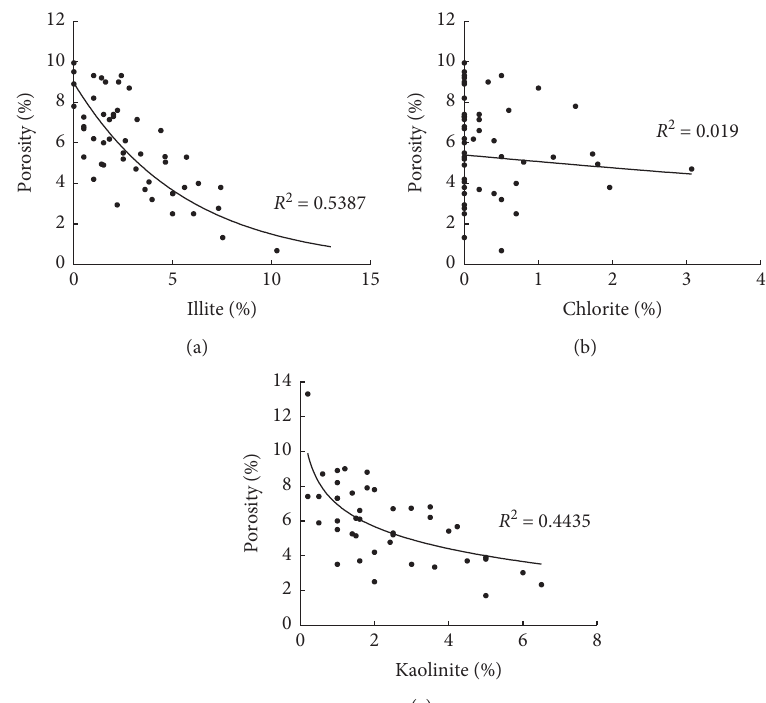
Figure 9: The relationships between diagenetic minerals and reservoir